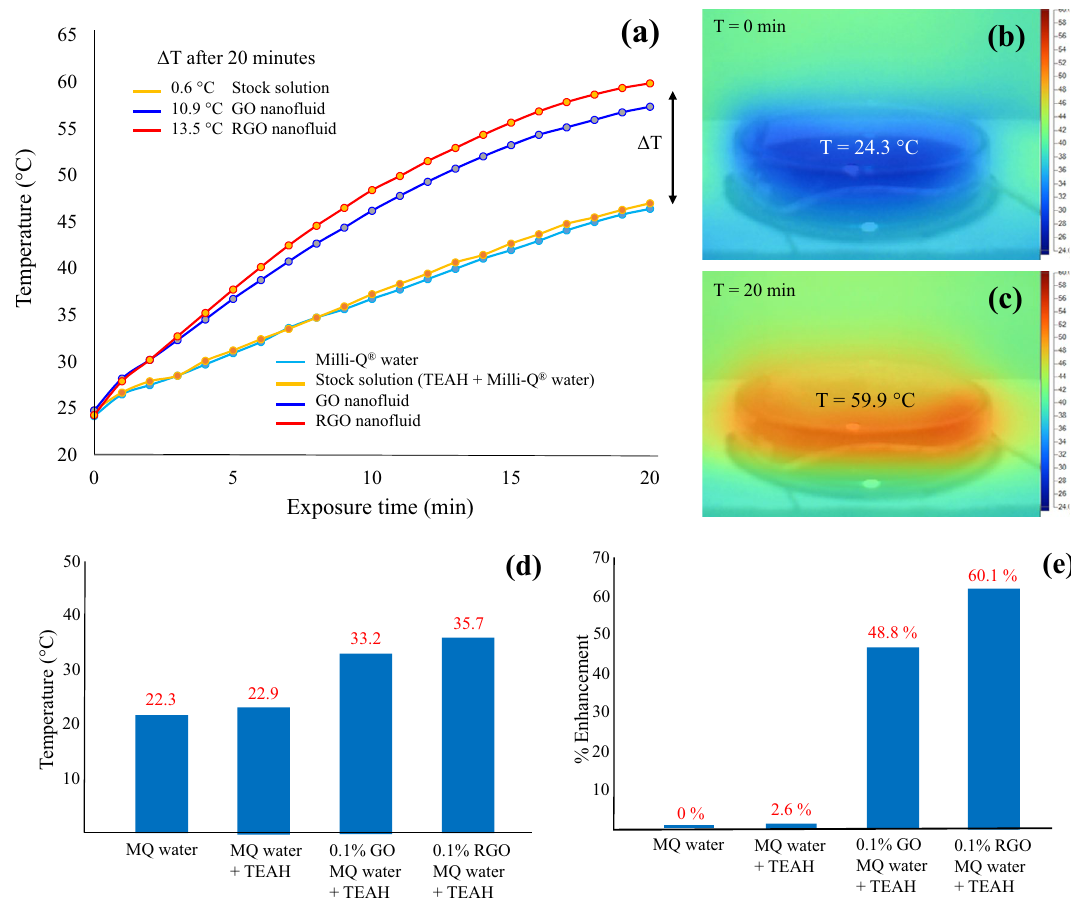
Figure 6. ( a ) Photothermal response of base fluids, GO and RGO nanofluids and ( b , c ) thermographs of RGO- based nanofluid taken over 20 min while exposed to solar irradiation. The temperature rise profile of the various nanofluids are shown ( d ) and ( e ) represents the % of phtothermal response enhancement with respct to MQ